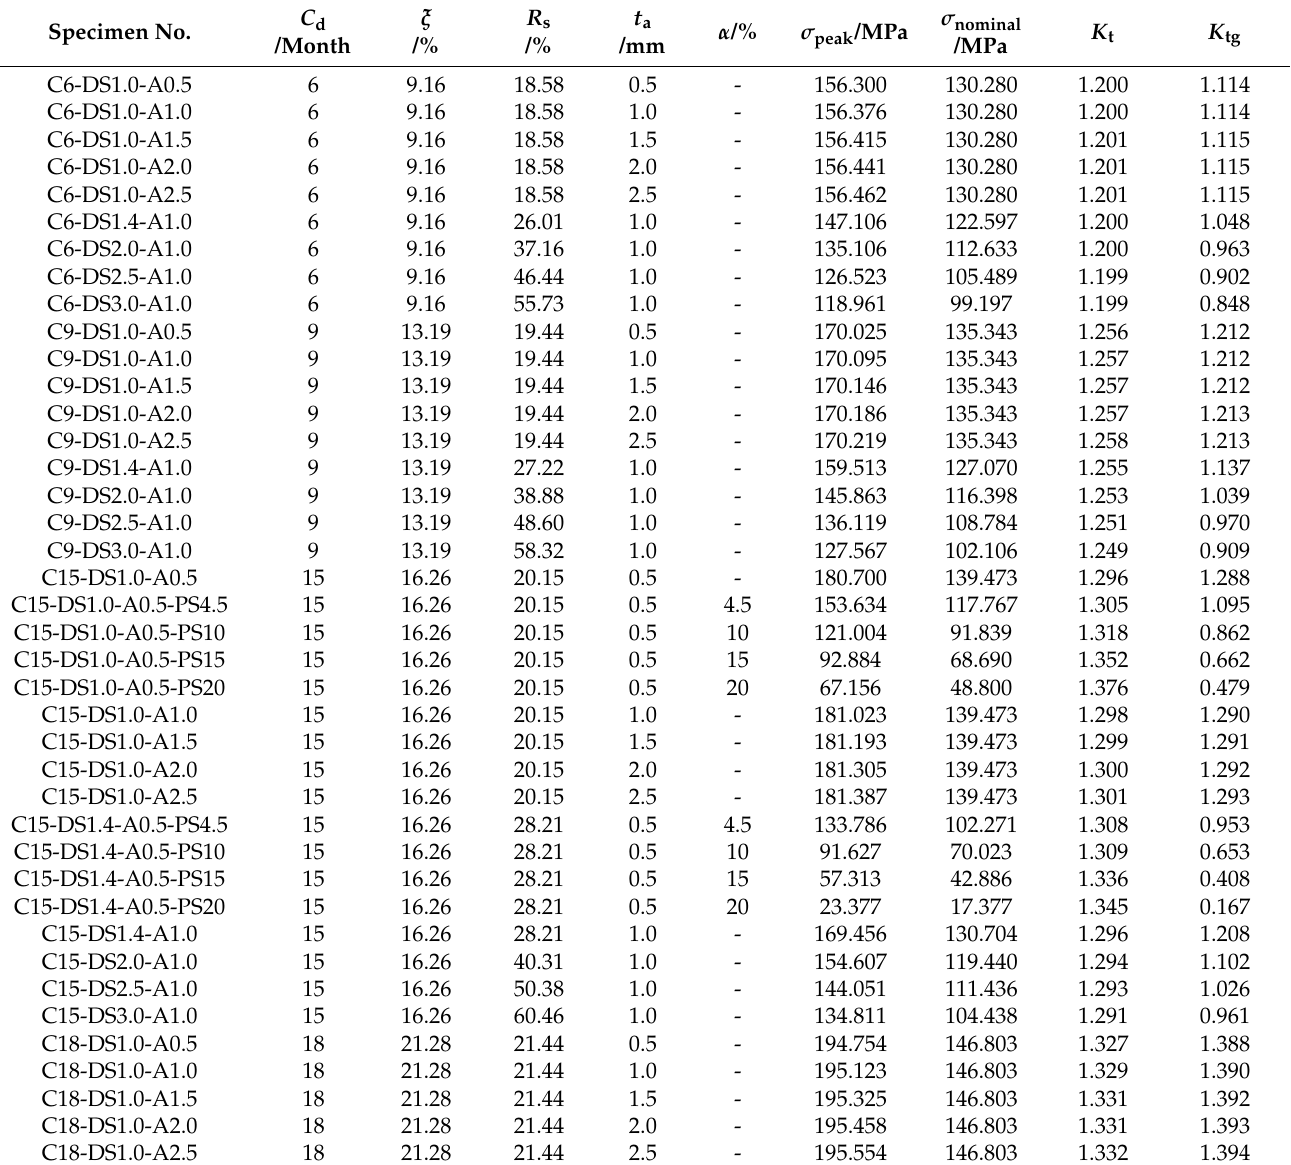
Table 2. Results summary of stress concentrations analysis of corroded steel plate strengthened with CFRP